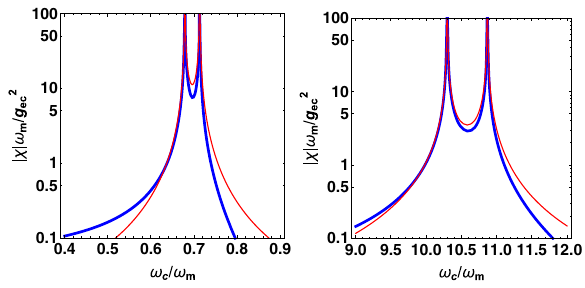
10 , g= ω 1 . 2164 =g 2 FIG. 8. Quantity j χ j ω for t= ℏ ω m m ¼ m ¼ ec = ω (for which a ¼ 0 . 05 ) as a function of ω in two different c m regions of the spectrum: close to ω 10 < ω 12 and close to δ δ 00 < 11 , left and right panels, respectively. The thick blue line gives the numerical calculation, the thin red line the expressions (22) and (23), shown in the left and right panels,